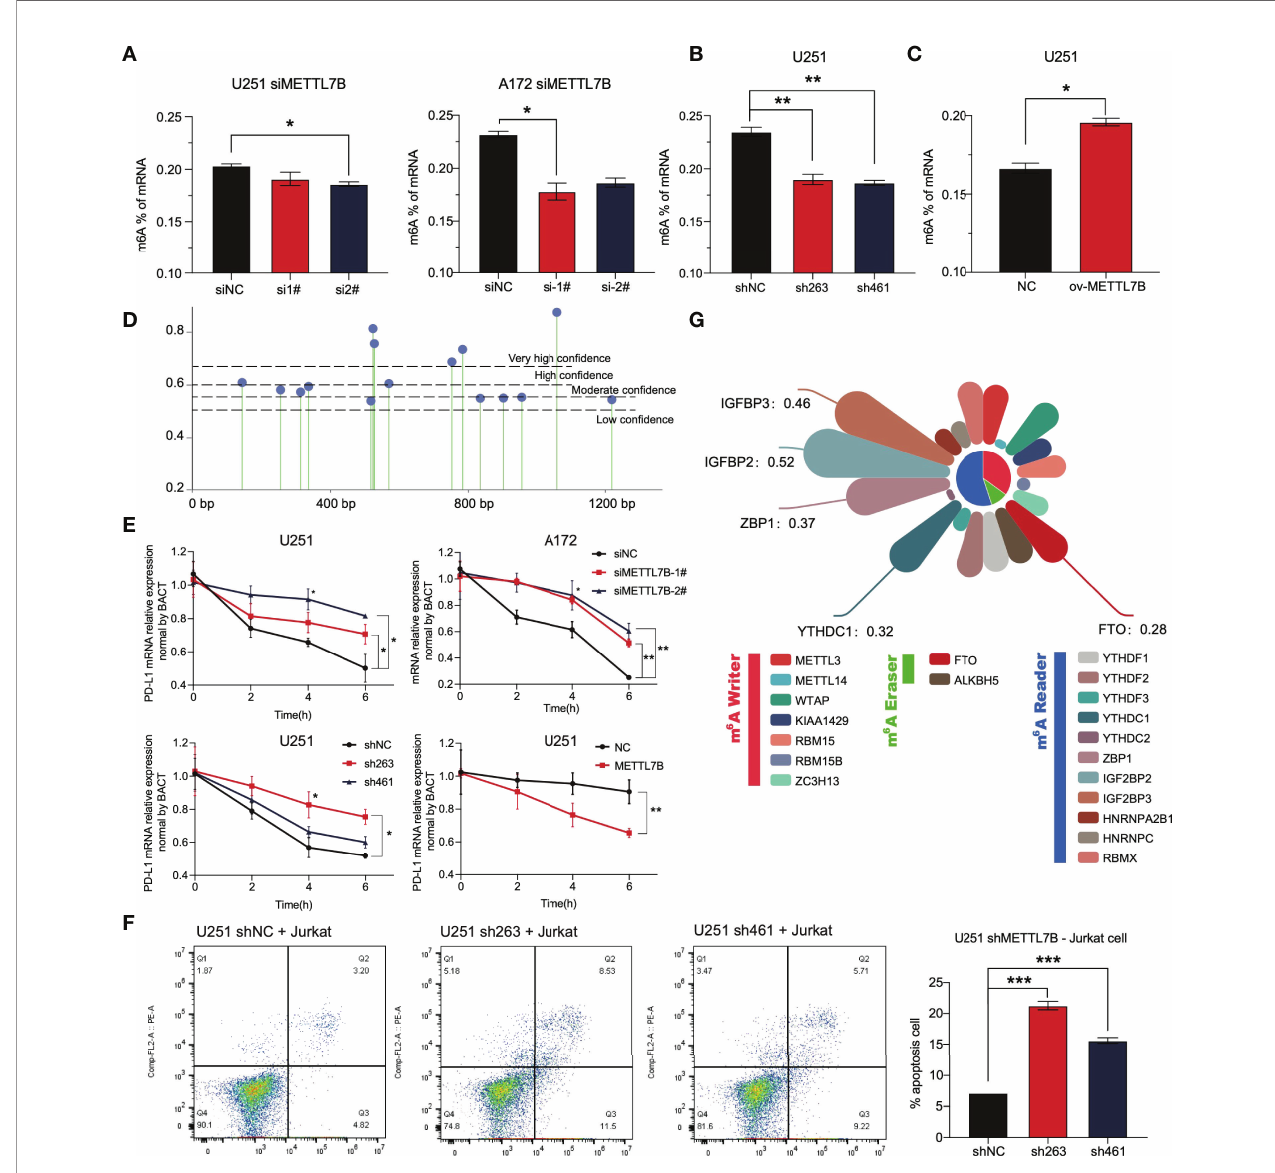
FIGURE 9 | The change in METTL7B in glioma through m6A modi fi cation affects the stability of PD-L1 mRNA. (A) In U251 and A172 cells transfected with siMETTL7B, the total level of m6A modi fi cation decreased signi fi cantly. (B) In the U251 shMETTL7B cell line, the whole level of m6A modi fi cation decreased signi fi cantly. (C) In U251 cells overexpressing METTL7B, the total level of m6A increased signi fi cantly. (D) The potential m6A modi fi cation sites on PD-L1 mRNA molecules were predicted based on SRAMP. (E) Actinomycin D (10 µg/mL) inhibited the transcription of nascent RNA in different treatment groups. Cells were collected at 0 h, two h, four h, and six h. The PD-L1 mRNA content in cells was detected by qRT – PCR. (F) The U251 shMETTL7B cell line was incubated with suspended Jurkat lymphocytes for 24 hours (10:1), and the supernatant was collected to detect lymphocyte apoptosis. (G) Correlation coef fi cient between METTL7B and RNA m6A modi fi cation-related molecules in low-grade gliomas. *p < 0.05, **p < 0.01, ***p <